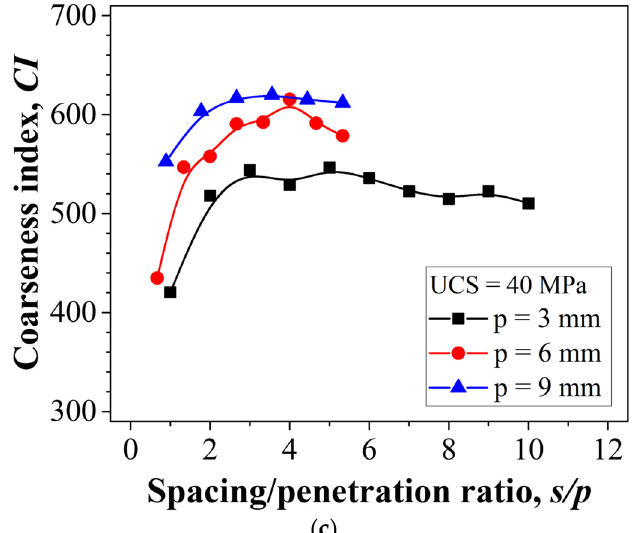
Figure 9. Relationship between CI and s / p ratio: ( a ) rock of UCS 20 MPa; ( b ) rock of UCS 30 MPa; ( c ) rock of UCS 40 MPa.